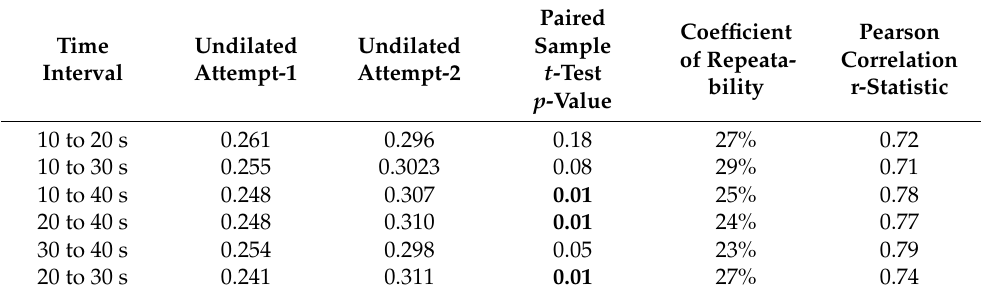
Table 6. Lutein optical density measurements obtained through physiological undilated pupillary conditions.